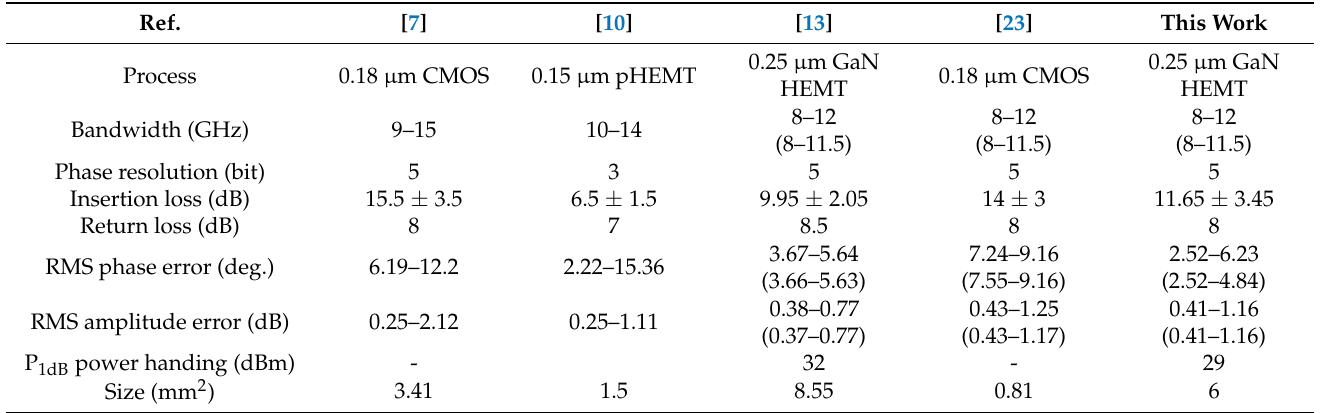
Table 3. Comparison of monolithic microwave integrated circuit MMIC phase